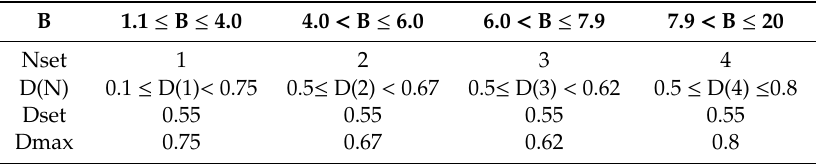
Table 4. The appropriate selection of D and N ( R Load = 250 Ohm).